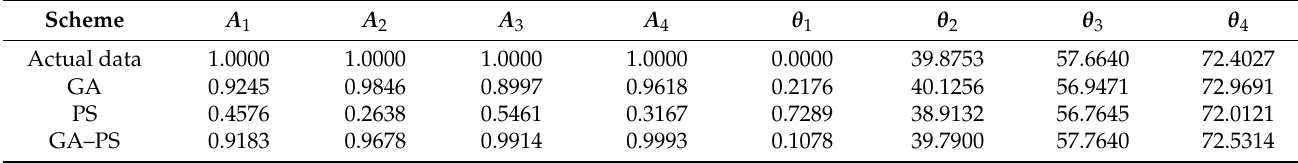
Table 8. Comparison of DOAs achieved using GA, PS, and GA–PS.